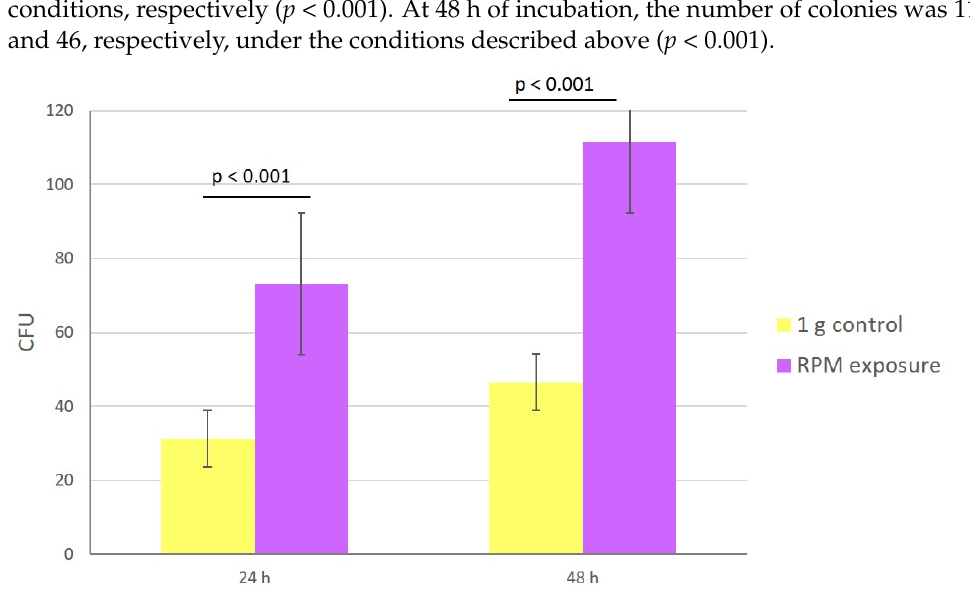
Figure 3. Impact of microgravity on spore germination. Percentage of germination under simulated microgravity (purple) and 1 g control (yellow) conditions at 24 and 48 h of incubation. The experi- ment was performed twice for all 8 strains subjected to 1 g control or RPM conditions. Data are the mean ± SEM. Statistically significant differences were observed using the Student’s t test.